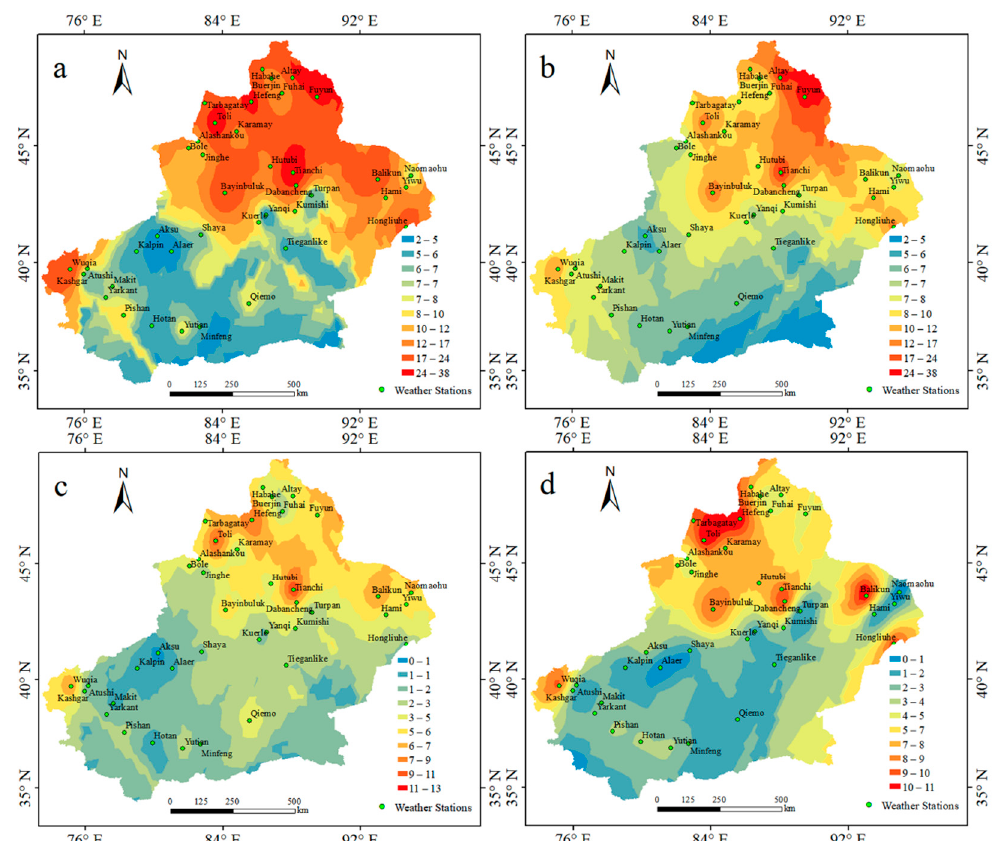
Figure 2. Spatial distribution of spring frost occurrence frequency in Xinjiang. Total frequency ( a ), frequency of mild spring frost ( b ), frequency of moderate spring frost ( c ), frequency of severe spring frost ( d ).